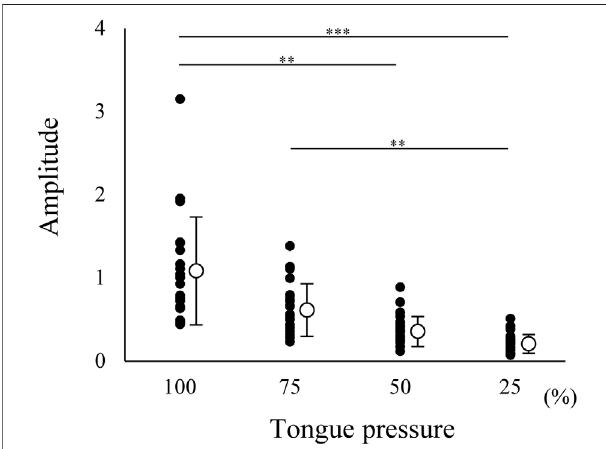
FIGURE 5 | Normalized amplitude of electromyographic burst of suprahyoid muscles during tongue pressure generation at 25, 50, 75, and 100% maximum effort. Open circles indicate mean values. Each value was normalized to that during maximum jaw-opening for each participant. Suprahyoid activity increased with increasing tongue pressure; 0.247 ± 0.114 for 25%, 0.396 ± 0.180 for 50%, 0.650 ± 0.313 for 75%, 1.112 ± 0.644 for 100%. *** p < 0.001, ** p <